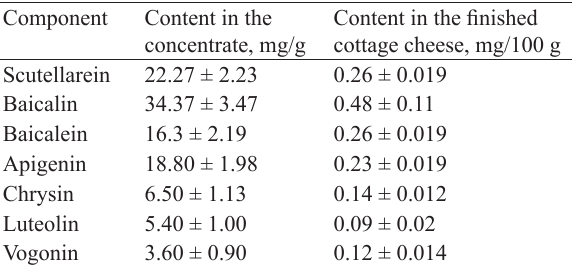
Figure 8 Flow chart for the cottage cheese fortified with biologically active substances extracted from Scutellaria galericulata L. Table 5 Main flavonoids in the cottage cheese fortified with biologically active substances extracted from Scutellaria galericulata L.